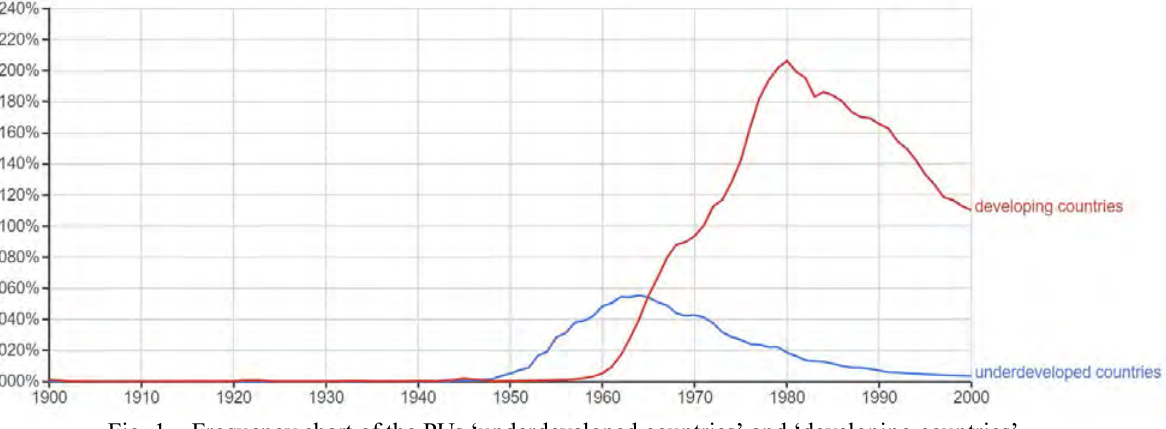
Fig. 1 – Frequency chart of the PUs ‘underdeveloped countries’ and ‘developing countries’